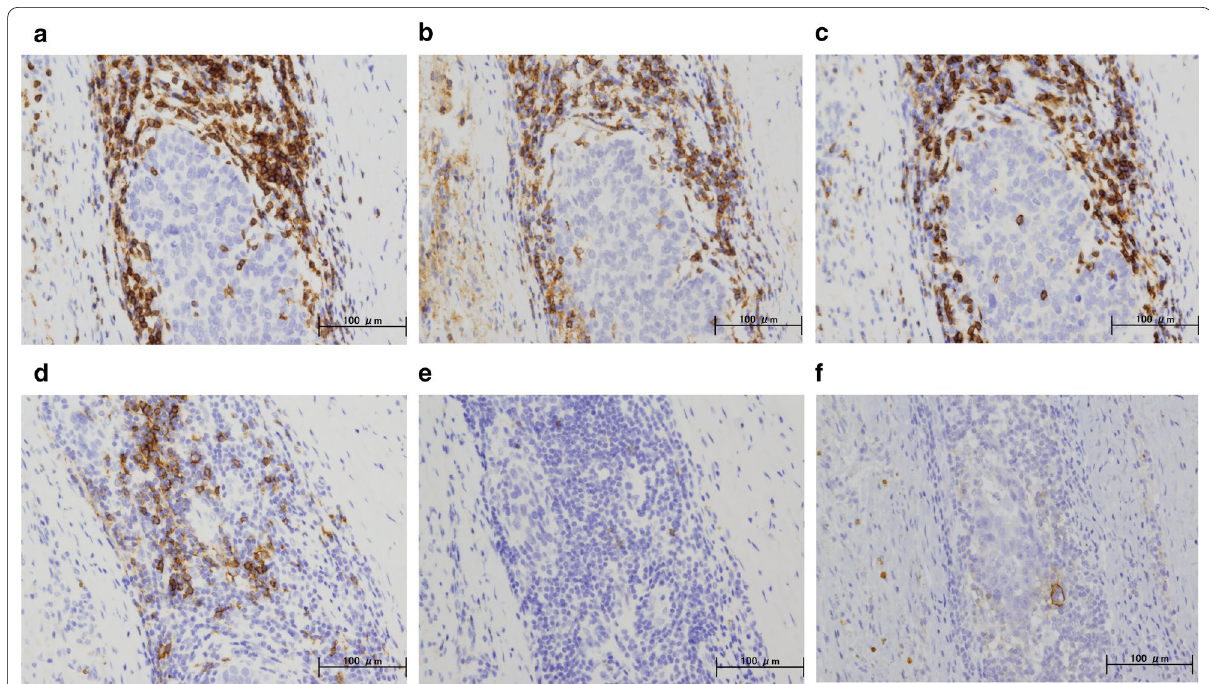
Fig. 5 Immunohistochemical staining for the primary breast cancer. Immunohistochemistry study for immunological surface markers ( a CD3; b CD4; c CD8; d CD20; e CD56; f PD-L1. All original magnifications are 200). Immunohistochemical staining for the primary breast cancer. × CD3-positive ( a ), CD4-positive ( b ), and CD8-positive T-cells ( c ), aggregation of CD20-positive B-cells ( d ), and occasional CD56-positive NK cells are detected ( e ). Ductal carcinoma cells are immunonegative for PD-L1 ( f